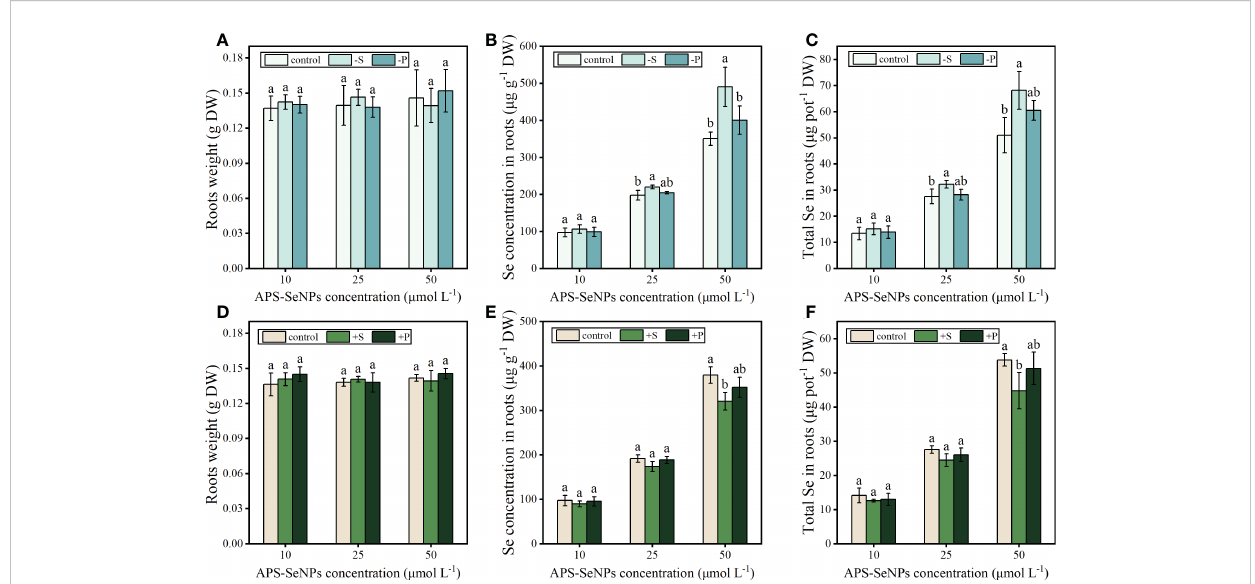
FIGURE 4 Effect of phosphorus (P) and sulfur (S) de fi ciency (A – C) or P and S supplementation (D – F) on the root weight and the uptake and accumulation of APS-SeNPs in rice. Data are presented as the mean ± SE ( n = 4).Different letters indicate signi fi cant differences between treatments at p < 0.05 according to Duncan ’ s test.